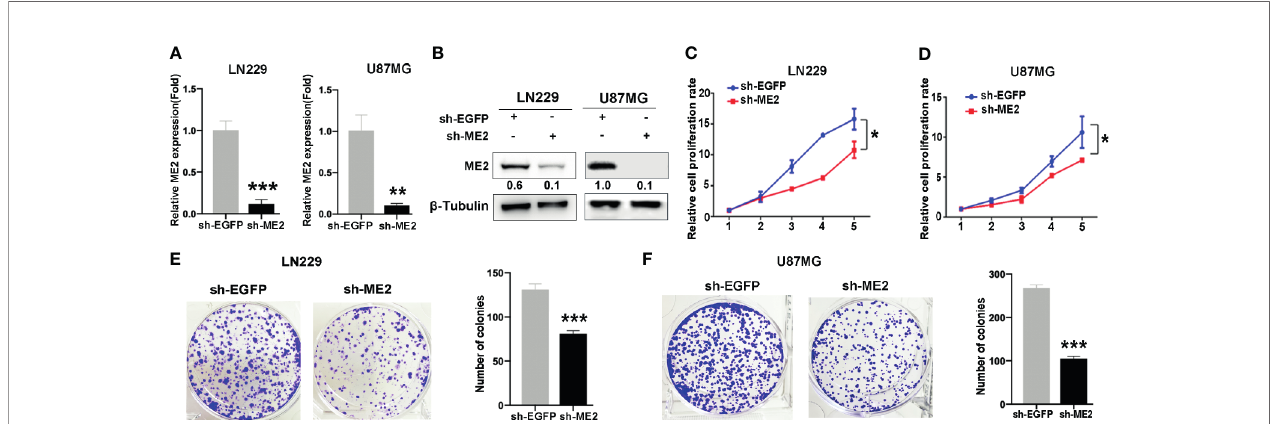
FIGURE 4 | Knockdown of ME2 inhibits cell proliferation in LN229 and U87MG cells. (A) Con fi rmation of the ef fi ciency of ME2 knockdown in LN229 and U87MG cells transfected with sh-EGFP or sh-ME2 plasmids by real-time PCR (**P < 0.01, ***P < 0.0001). (B) Western blot to con fi rm ME2 expression in LN229 and U87MG cells transfected with sh-EGFP or sh-ME2 plasmids. (C, D) CCK-8 assay to determine the effects of ME2 overexpression on proliferation of LN229 and U87MG cells (*P < 0.05). (E, F) Colony formation assay to determine the colony formation of ability in the above glioma cell types (***P < 0.0001).